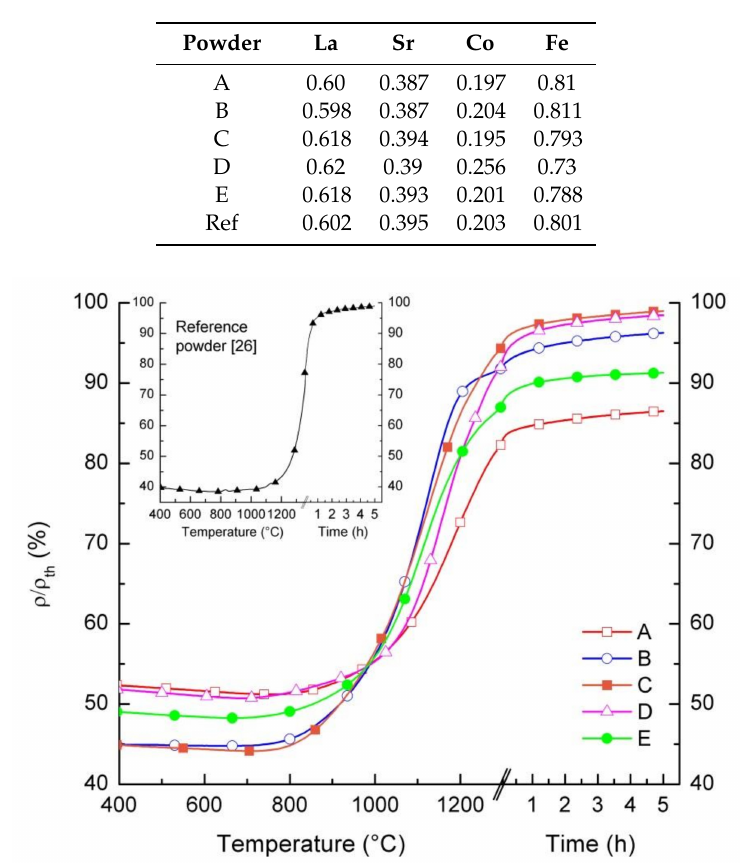
Table 2. Stoichiometry of the LSCF powders, as determined by inductively coupled plasma optical emission spectroscopy (ICP-OES) measurements with a precision of 1–3% for major elements. For all values, the standard deviation is ≤ 0.02.